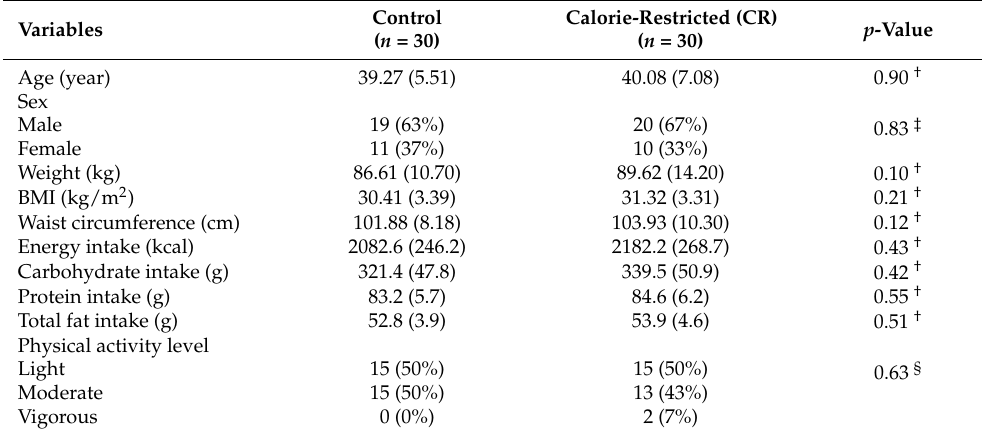
Table 1. Baseline characteristics of the study